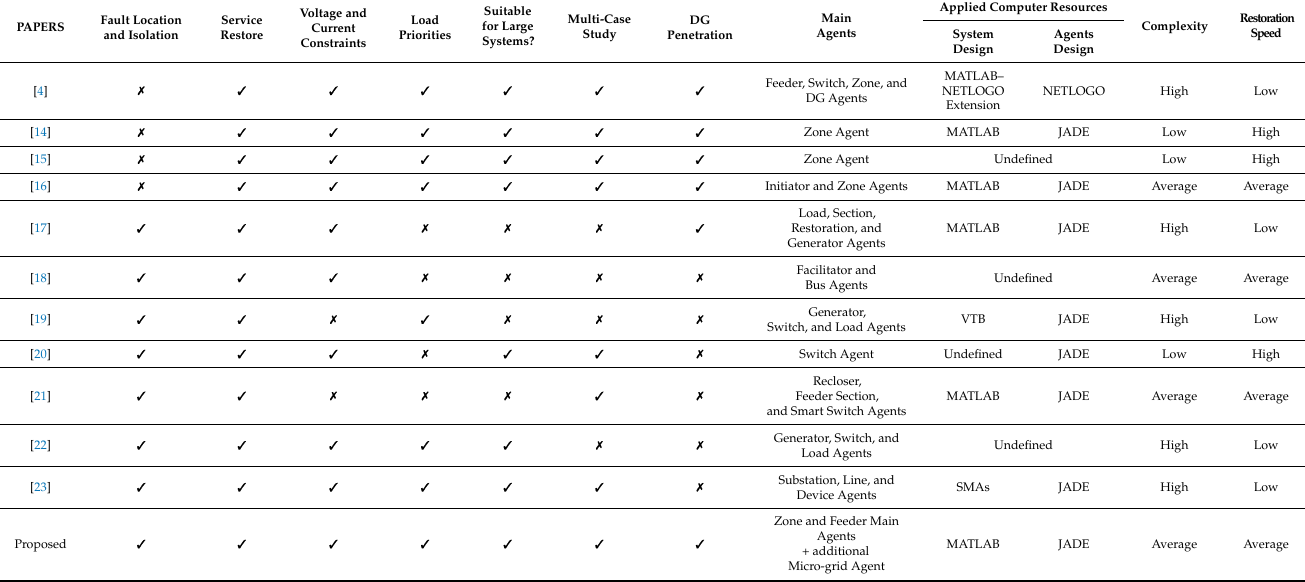
Table 4. The proposed algorithm versus other MAS self-healing algorithms in related